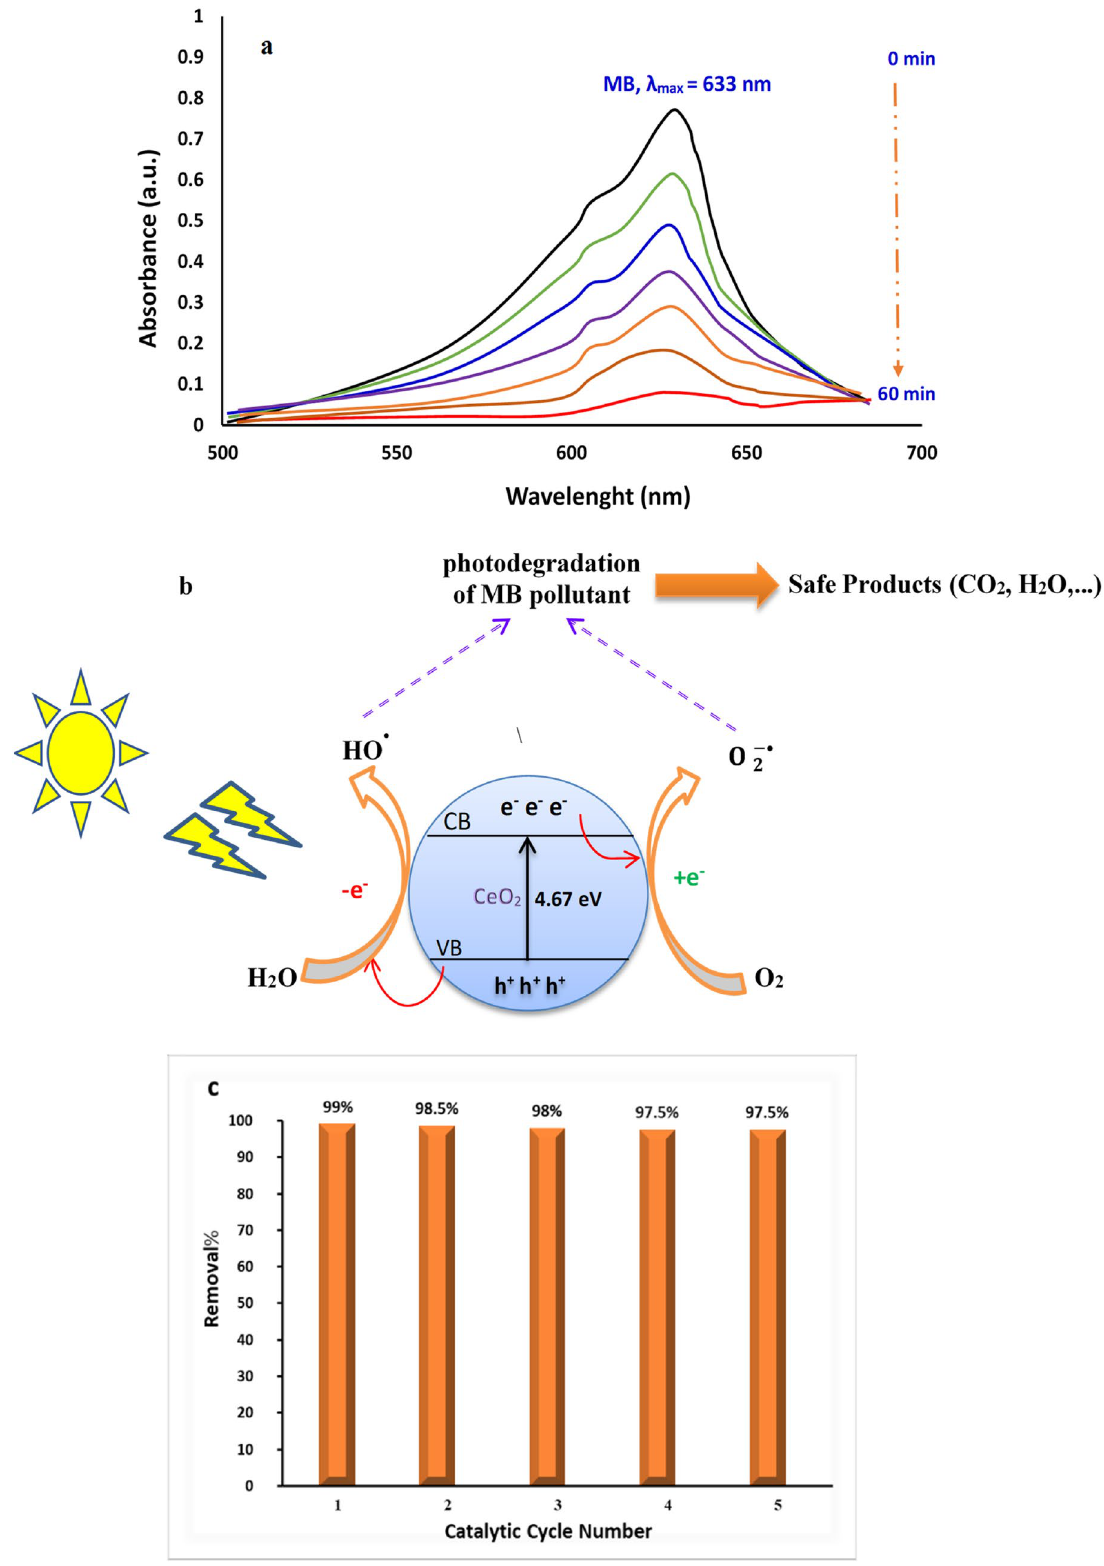
Figure 10. ( a ) Photocatalytic activity, ( b ) mechanism, and ( c ) recyclability of marine-mediated nanoceria against toward MB contaminant in aqueous